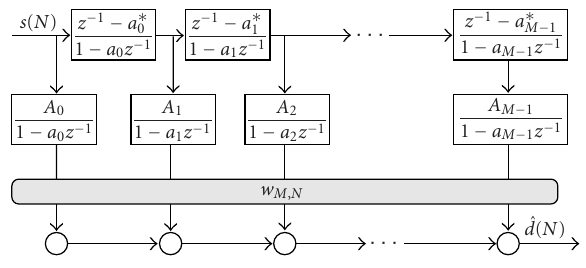
Figure 1: Transversal orthonormal structure for adaptive